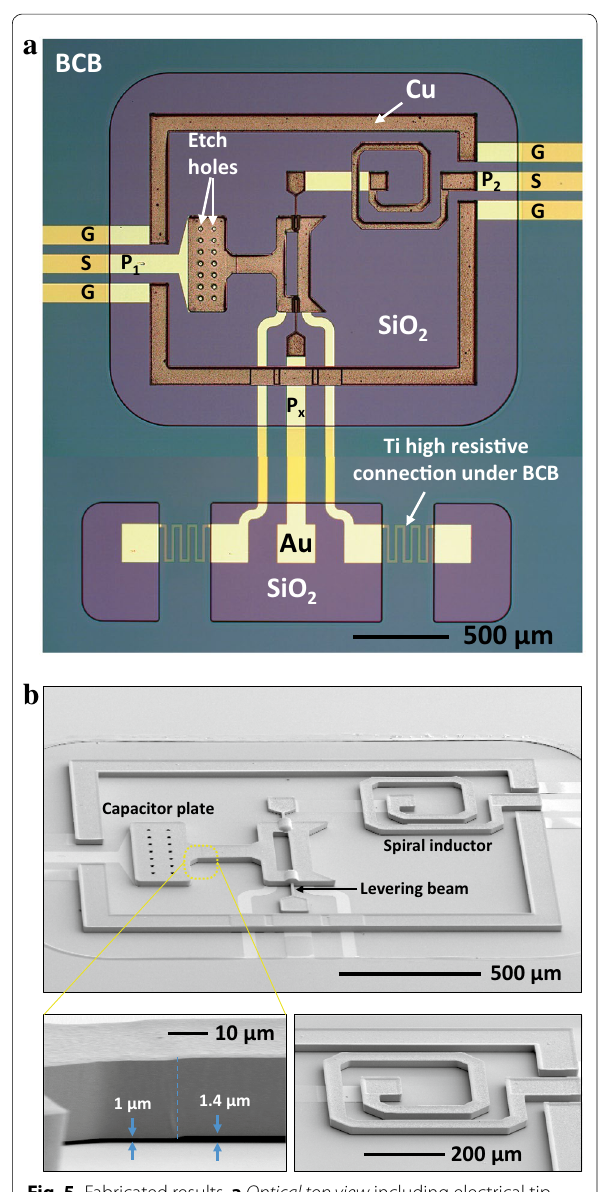
Fig. 5 Fabricated results. a Optical top view including electrical tip‑ ping pad below the LC device. b SEM images of the proposed device ( upper ), magnified view of the actuator beam showing the height of g cap and g tune ( lower left ), and serially connected suspended spiral inductor ( lower right